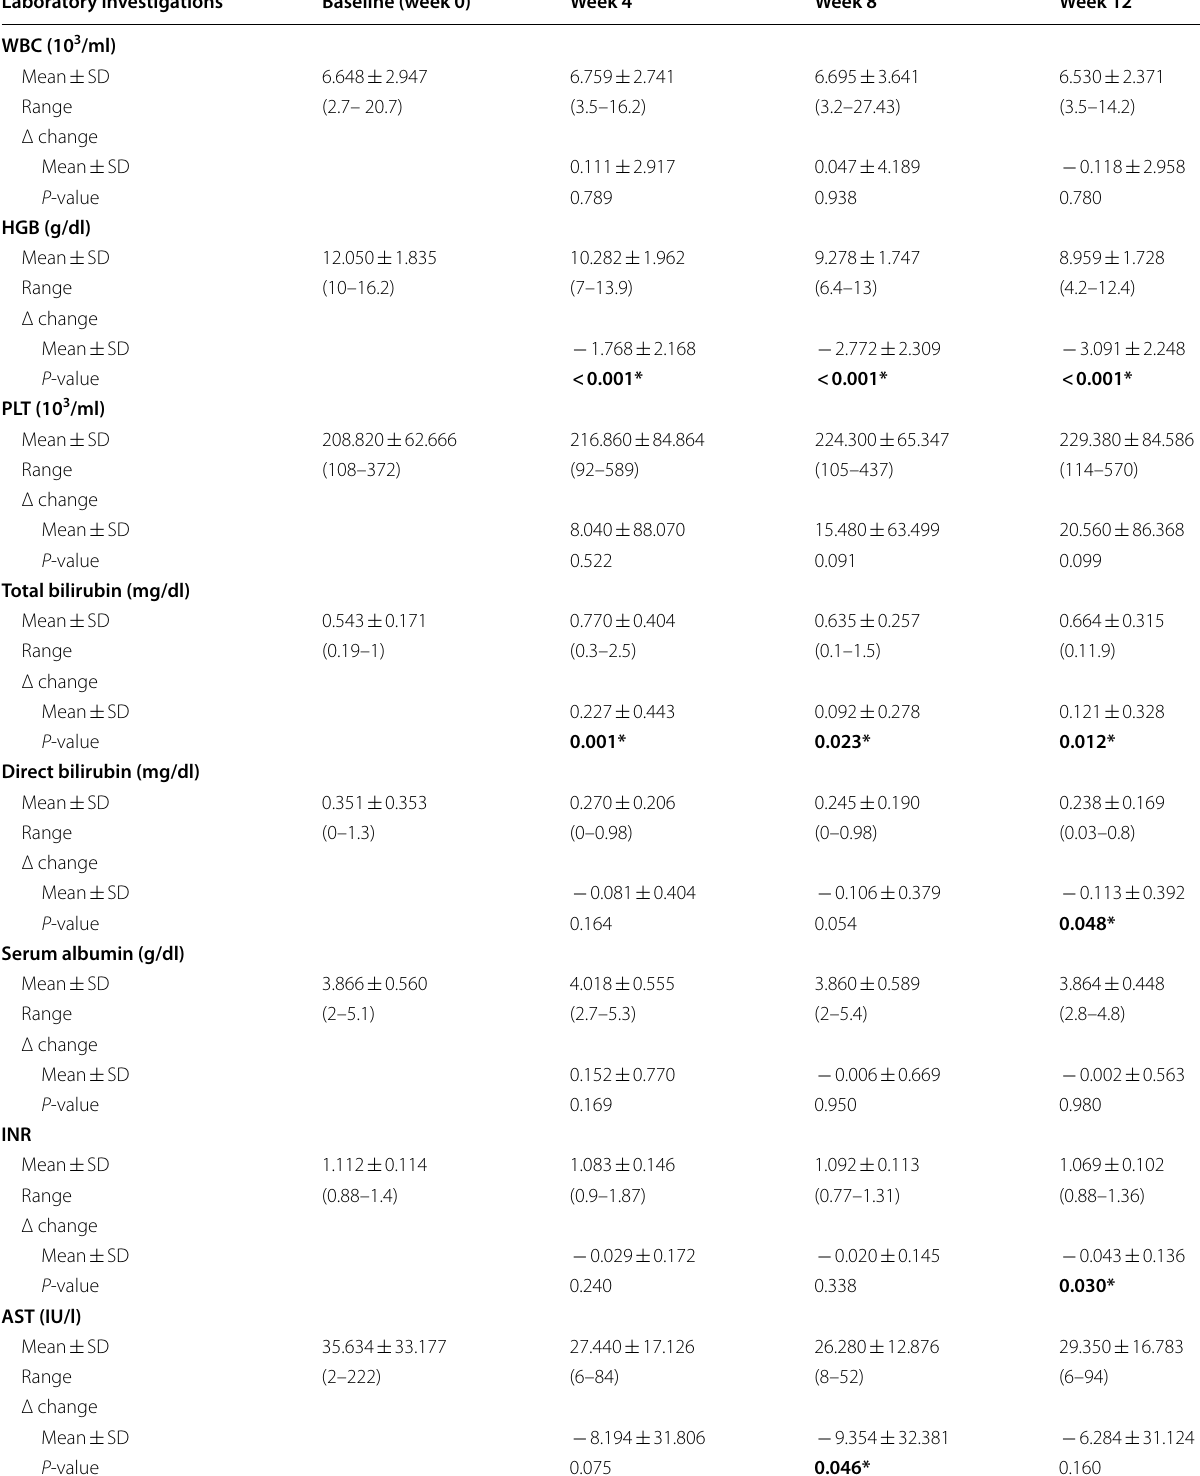
Table 2 Comparison between baseline (week 0) and Δ change in laboratory investigations from baseline at weeks 4, 8, and 12 as regards blood counts and liver function